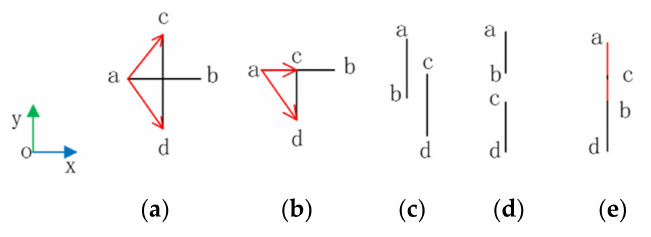
Figure 6. Intersection of two line-segments in a plane; ( a , b ) shows the two line-segments are perpendicular; ( c – e ) shows the two line-segments are